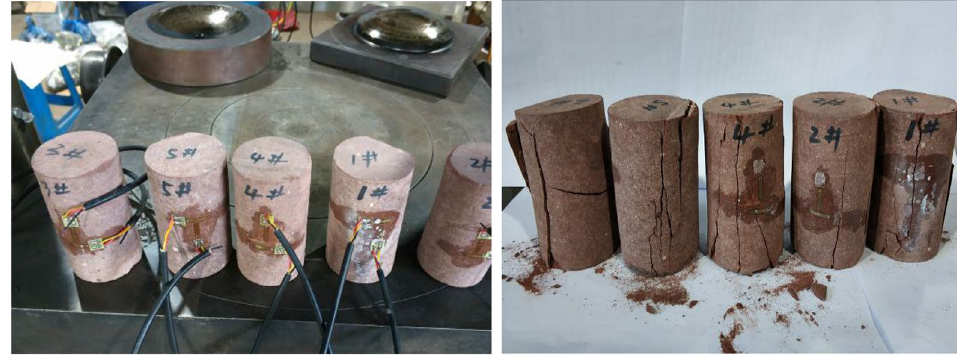
Fig. 5 Standard rock sample and the broken sample after test